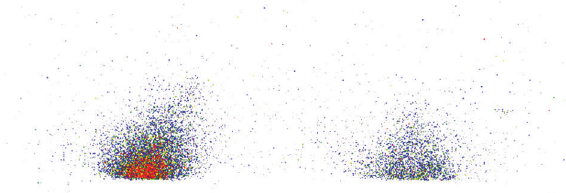
Figure 4: AD transgenic mice injected with 125 ICQ BCA NPs and 125 ICQ (Mice aged 7 mo; 90 minutes post injection).